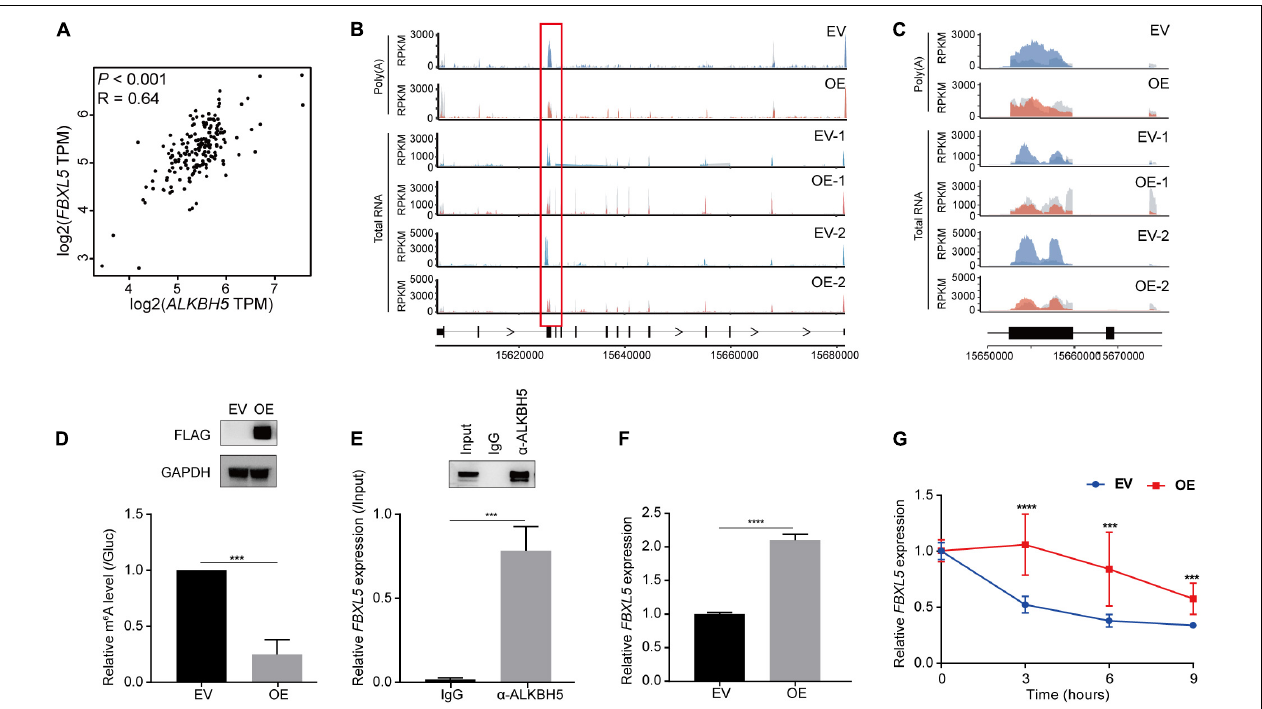
FIGURE 4 | ALKBH5 regulates the stability of FBXL5 RNA. (A) Expression correlation between ALKBH5 and FBXL5 across 178 pancreatic adenocarcinoma (PAAD) samples in TCGA database. R, Pearson correlation coefficient. (B) Sequencing reads density for input and m 6 A-IP samples along FBXL5 transcript in poly(A) RNA- and total RNA-based m 6 A-seq data. Hypo-methylated peaks are indicated in red rectangles. Gray for input libraries, while blue (EV) or red (OE) for IP libraries. X -axis, genomic coordinates; Y -axis, normalized number of reads. (C) Zoom-in of the hypomethylated region on FBXL5 transcript. (D) m 6 A-IP-qPCR results showing the methylation changes of FBXL5 between EV and OE samples. Results of Western blot analysis showing the expression of Flag-ALKBH5 are shown in the upper panel. GAPDH is used as an internal control. (E) RIP-qPCR results showing the interaction between ALKBH5 protein and FBXL5 RNA in MIA PaCa-2 cells. Results of Western blot analysis showing the efficiency of immunoprecipitation are shown in the upper panel. (F) RT-qPCR results showing the changes of FBXL5 expression between EV and OE samples. (G) Results of RNA stability assay showing the effect of ALKBH5 overexpression on the decay rate of FBXL5 RNA. EV, empty vector; OE, ALKBH5 overexpression. *** P < 0.001, **** P <